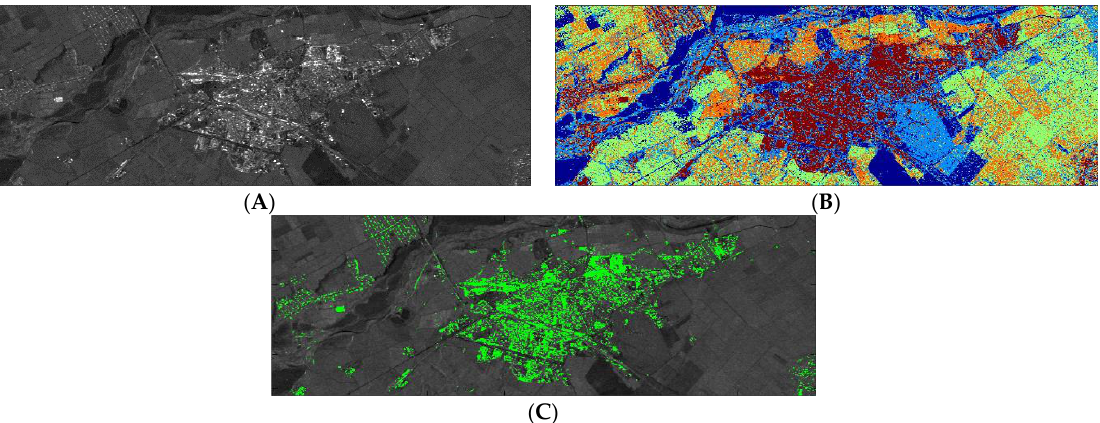
Figure 12. Multi-look ERS image amplitude, Buzau ( A ); Scene classification map presenting categories of evolution ( B ); spatial distribution of detected Persistent Scatterers ( C ).